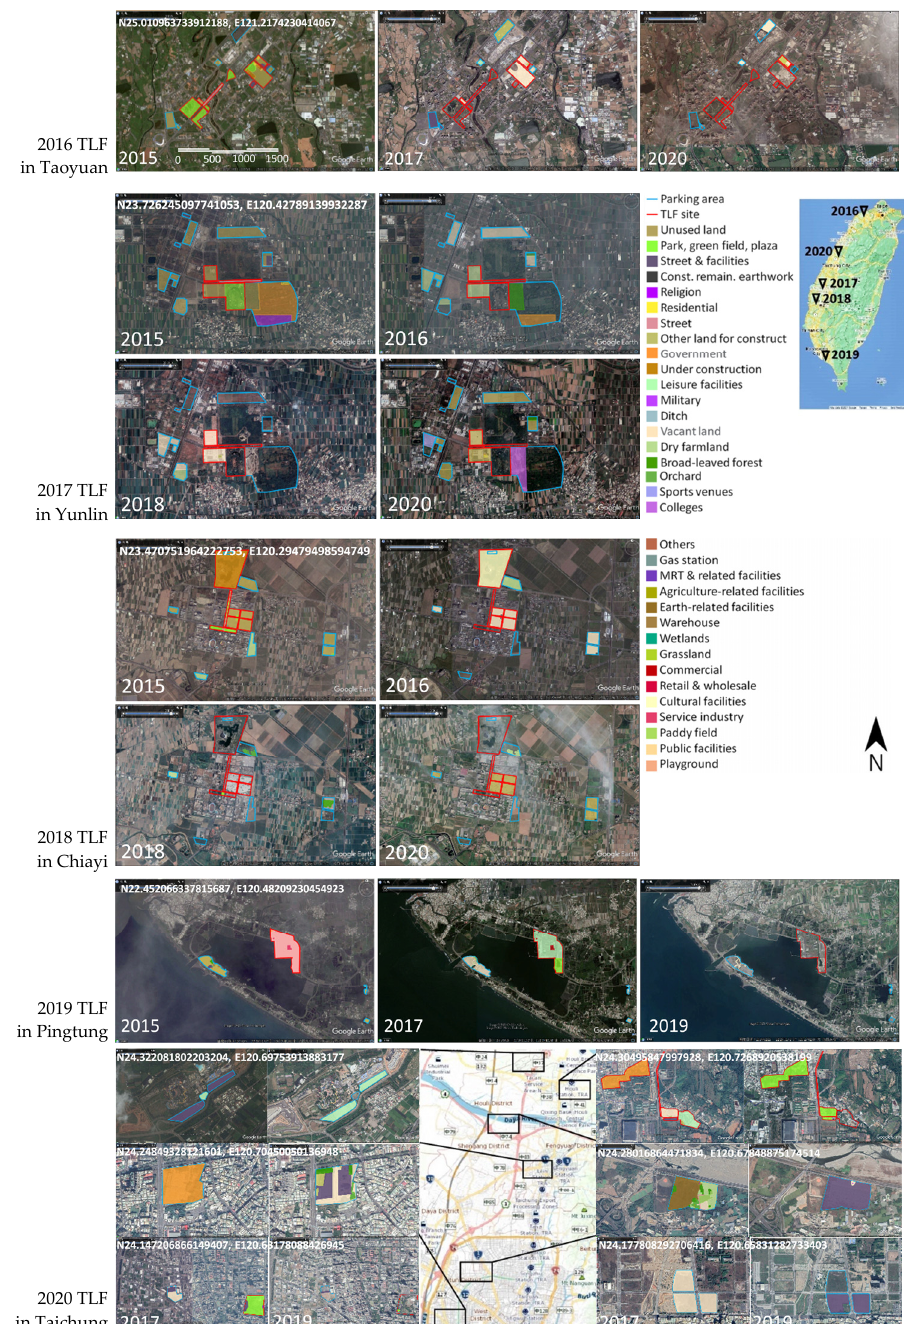
Figure 4. Satellite images illustrating the evolved urban fabric before and after the 2016 TLF in Taoyuan, the 2017 TLF in Yunlin, the 2018 TLF in Chiayi, the 2019 TLF in Pingtung, and the 2020 TLF in Taichung (from the top to bottom).